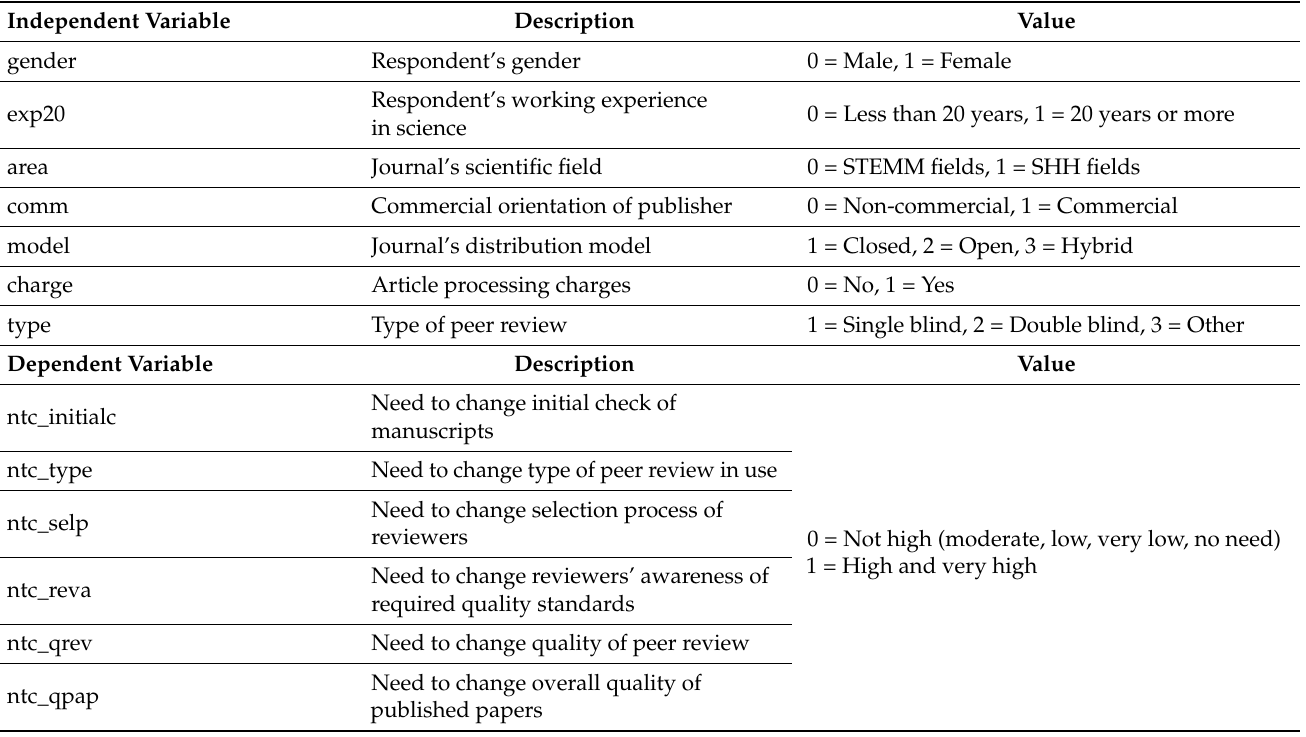
Table 3. List of independent and dependent variables for bivariate analysis.